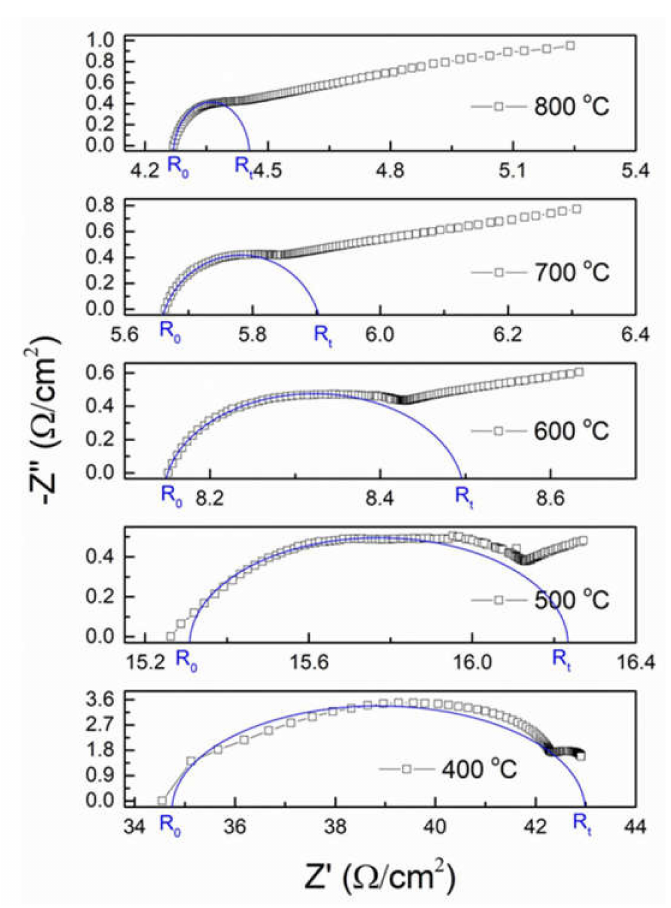
Figure 6. Complex impedance spectrum of the LSGM electrolyte at di ff erent temperatures in static